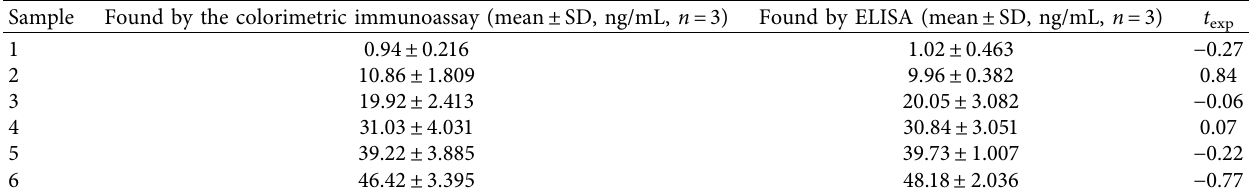
Figure 4: (a) Specificity, (b) antiinterference, (c) reproducibility, and (d) stability of Ab phosphate buffer solution (pH 7.0). Table 1: Comparison of the assay results for human serum specimens by using the developed colorimetric immunoassay and the referenced ELISA method.